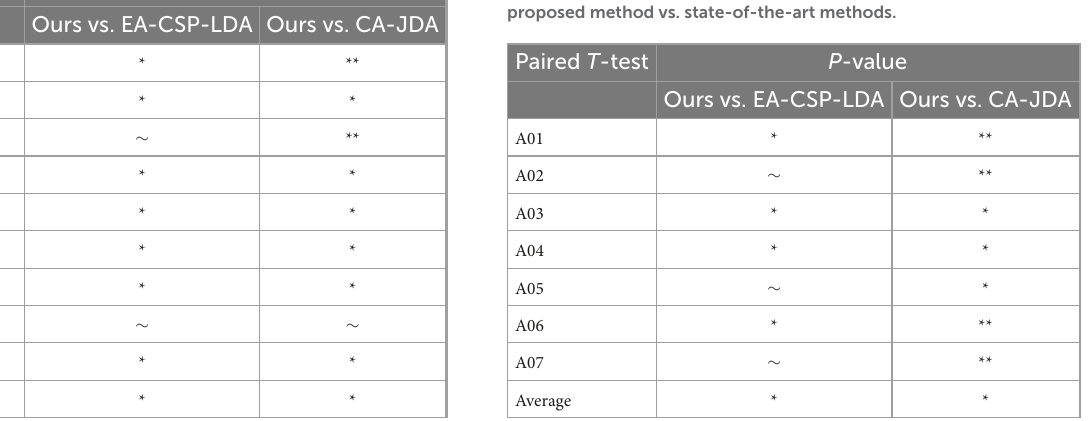
TABLE 4 Separate session of T -test statistical analysis for the proposed method vs. state-of-the-art methods. Paired T -test P -value